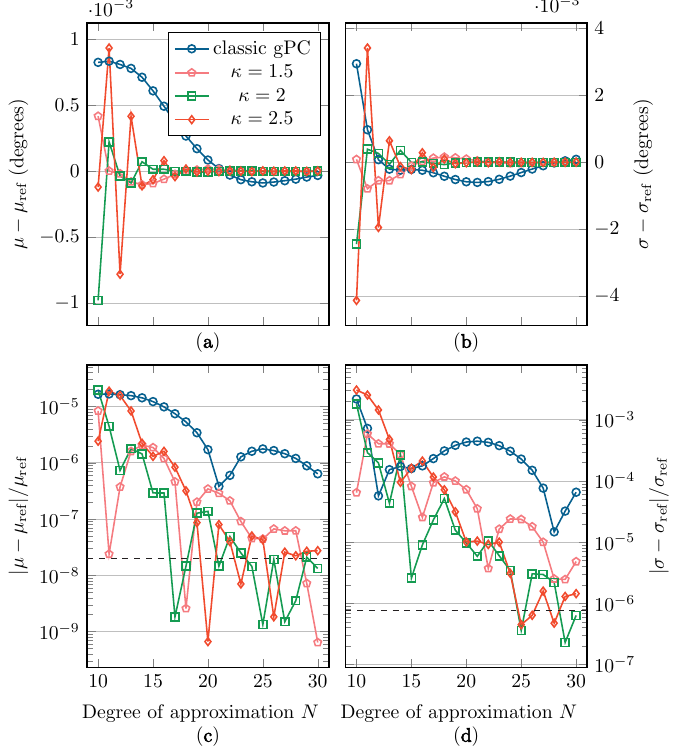
Figure 11. The absolute and relative errors on µ ( a , c ) and σ ( b , d ) with regard to their reference value when applying the Beta ( x ;2,2 ) distribution. The precision floor is shown by a dashed